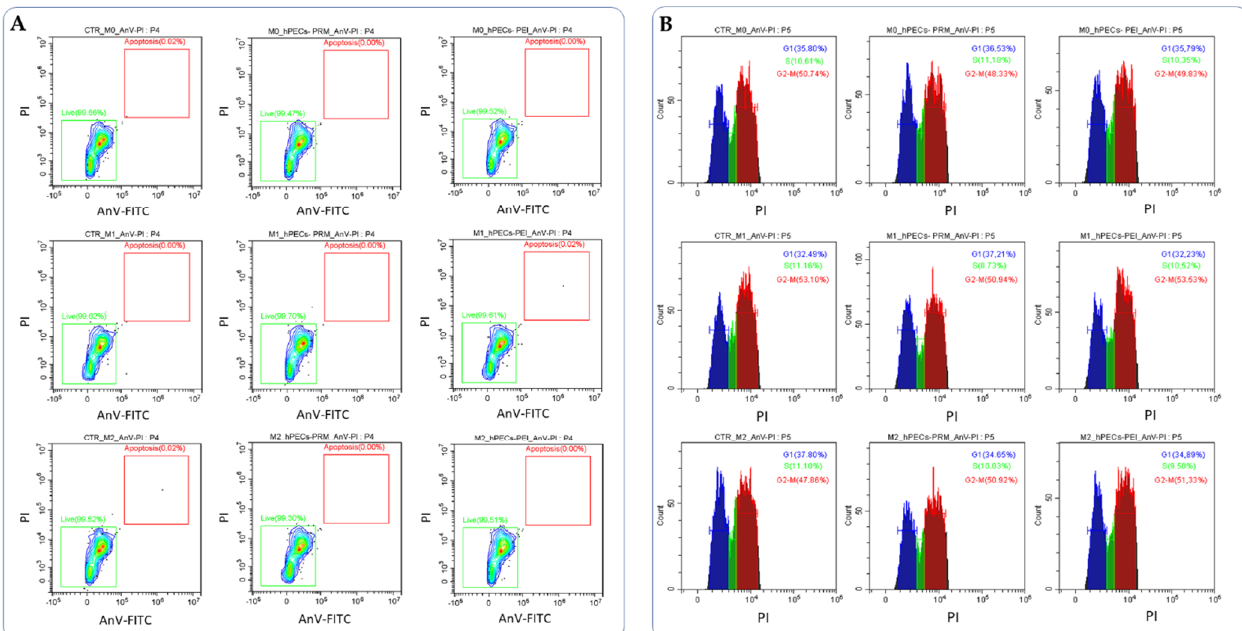
Figure 5. Cytofluorimetric analysis of cell apoptosis ( A ) and cell cycle ( B ) of THP-1 cells after 24 h of incubation with different hPEC formulations after M0, M1, and M2 polarization after 24 h of treatments compared with untreated control cells (CTR). Representative images of three independent experiments.